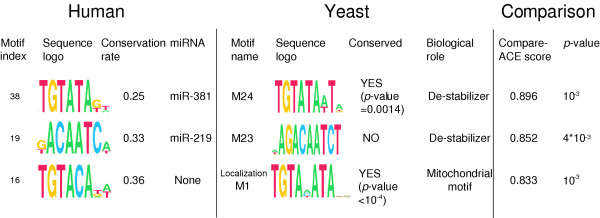
Examples of yeast 3' UTR motifs and their best mammalian counterpart 3' UTR motif. All 72 mammalian motifs were transformed into alignments and then PSSMs, and compared with all 53 yeast motifs using CompareACE [21]. The figure presents, for the mammalian motifs by Xie et al. [11] its motif index in the original paper, the sequence logo, conservation rate, and a corresponding miRNA which is presumed to bind the motif. For the yeast motif, the motif name, sequence logo, significance of conservation across four sensu stricto yeast species, and the potential biological role are shown. The CompareACE score for similarity between the mammalian and yeast motif, along with a p-value on it, are presented on the right-hand side of the figure.